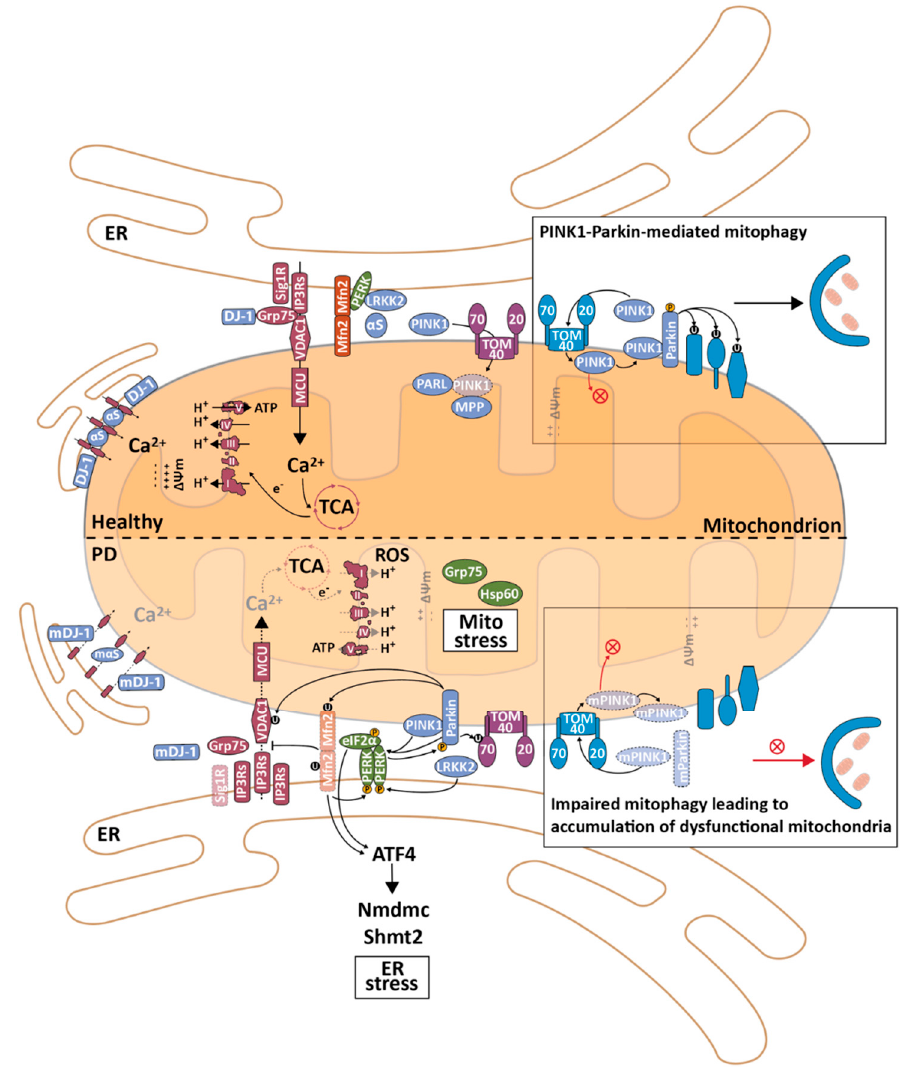
Figure 2. MERCS in health and in PD. In healthy controls (upper part of the figure), different functions of MERCS are integrated to maintain cell homeostasis. The IP3Rs-Grp75-VDAC1 complex together with the MCU complex allows the entry of Ca 2+ into mitochondria, where it can boost the TCA cycle, inducing ATP production. This complex, together with Mfn2, can also modulate the connectivity between the ER and mitochondria. Under normal conditions, PINK1 is imported into mitochondria, where it can be degraded by PARL and MPP. In cases where mitochondria are damaged, PINK1 import is unsuccessful, and this protein accumulates in the OMM, where it recruits Parkin. Parkin then ubiquitinates proteins at the OMM, inducing mitophagy. In familial PD, mutation in α -synuclein ( α S in the figure) increases MERCS, inducing Ca 2+ overflow inside mitochondria. However, PD-related mutations in DJ-1 (mDJ-1), α -synuclein (m α S), PINK1, Parkin and LRKK2 led to a decrease in MERCS. Nevertheless, these mutations lead to mitochondrial dysfunction, including mitochondrial stress and decreased ATP production as well as ER stress. PD mutations in PINK1 and Parkin (mPINK1 and mParkin in the figure) are usually associated with loss of function and therefore lead to impaired mitophagy activation, preventing the clearance of damaged mitochondria. Different colours correspond to proteins involved in different cellular processes and faded colours as well as dashed lines represent the downregulation of the process or protein level/function. Red arrows as well as red cross correspond to blocked/impaired